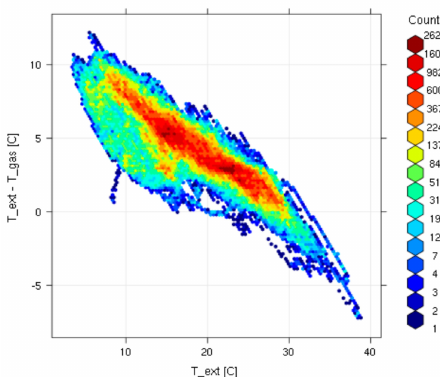
Figure 12. Bivariate analysis of T ext - T gas ( y -axis) as a function of T ext ( x -axis). The colored scale (see legends) represents the number of data